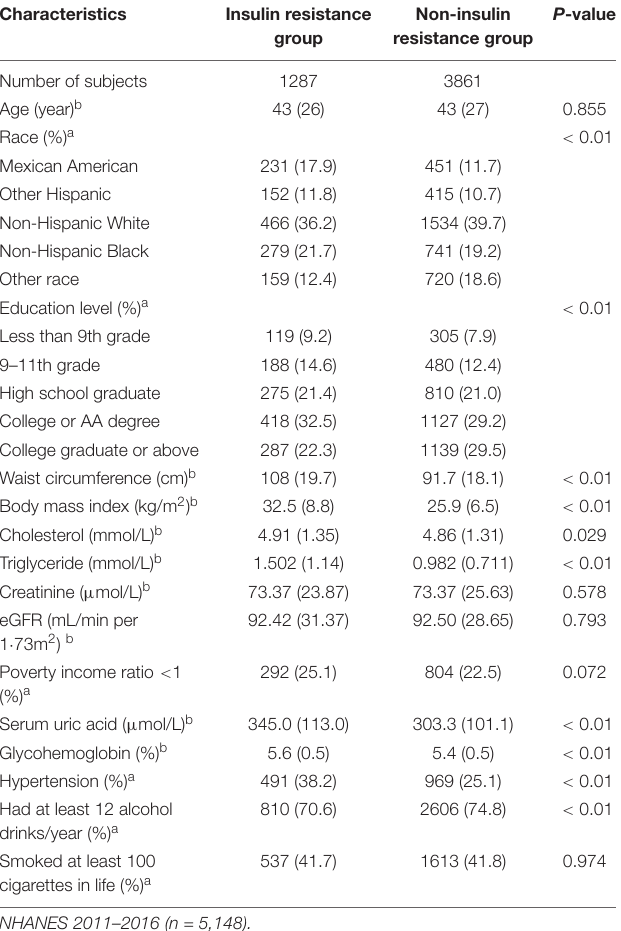
TABLE 3 | Clinical characteristics of the study population in insulin resistance and non-insulin resistance group.